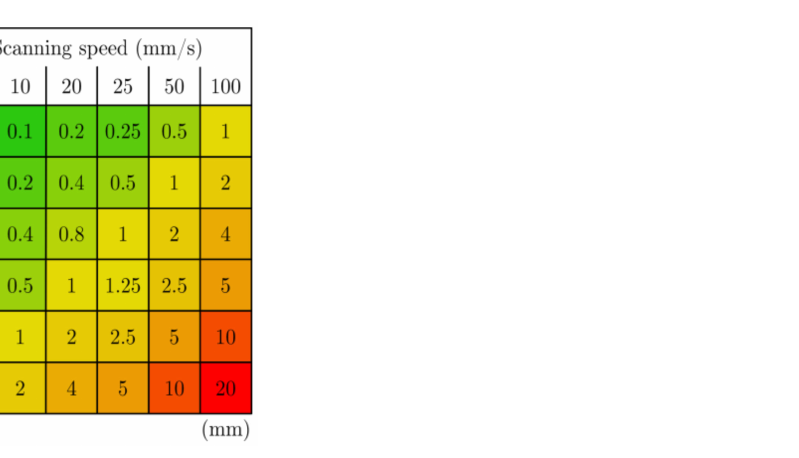
Figure 3. Sampling resolution (mm) for different combinations of scanning speeds (mm/s) and sampling frequencies (Hz).